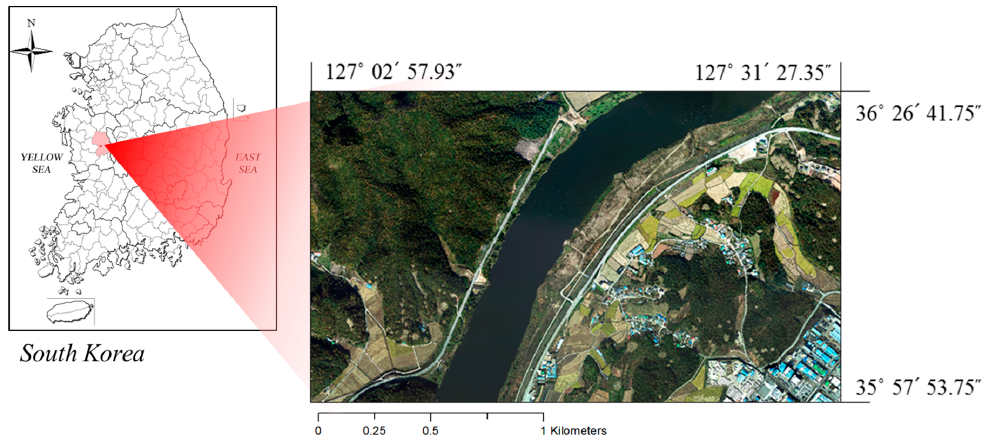
Figure 1. Location of the study area in Gongju province, South Korea. The red-green-blue (RGB) aerial orthophoto shows the spatial distribution of forests in the study area.